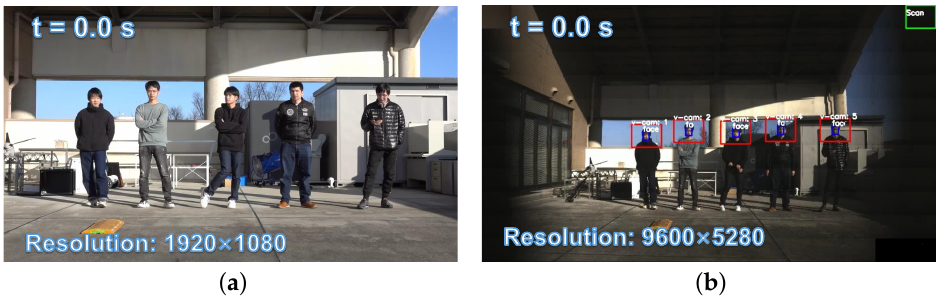
Figure 17. The 1920 × 1080 input images from the digital camera and panoramic stitched 9600 × 5280 images from the PTZ camera: ( a ) input image of the digital camera and ( b ) panoramic stitched image from the PTZ camera.